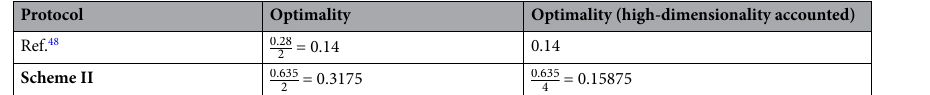
Table 5. Comparison between Scheme II and existing relativistic QKD protocol 48 in terms of optimality F ( d ) for d = 10 km. When high-dimensionality (usage of two encodings) is accounted, the amount Q (Eq. 7) is doubled.